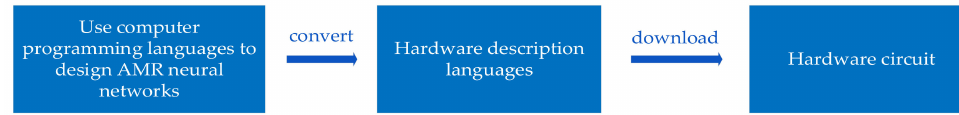
Figure 14. Using hardware circuit to implement the DL-based AMR